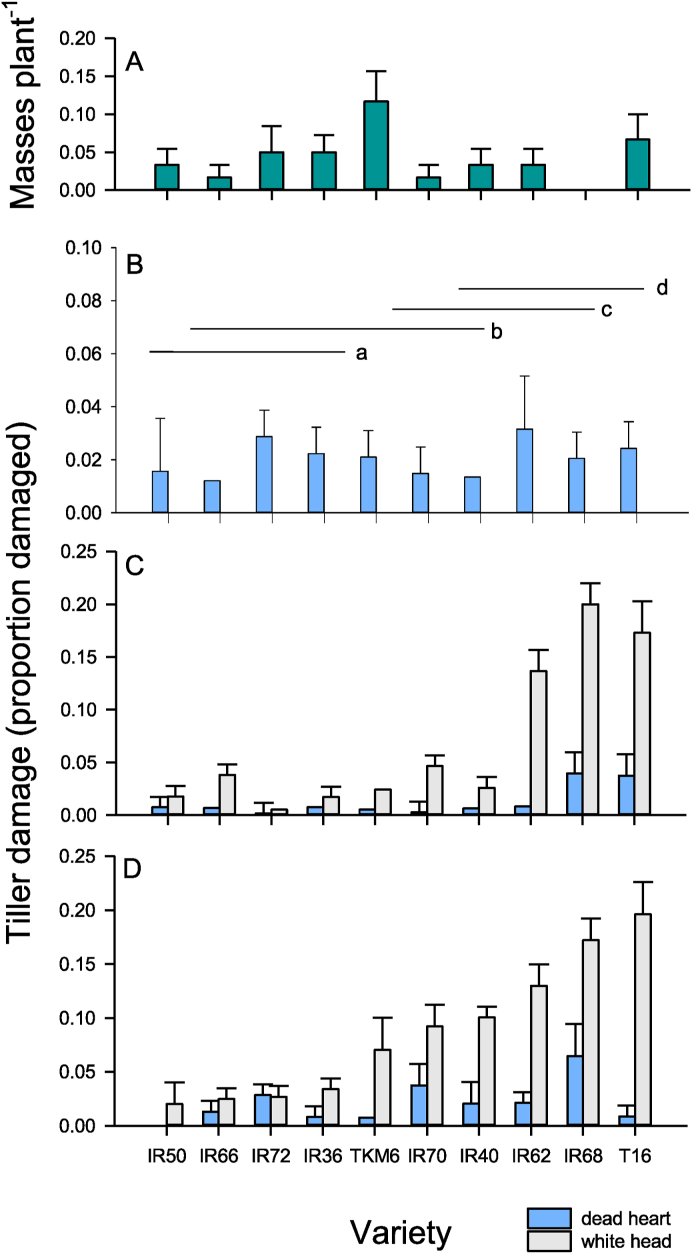
Results from field experiment with ten rice varieties. Data indicate (A) the number of YSB egg masses recorded in plots at 15 days after transplanting and tiller damage at (B) early, (C) mid, and (D) late season sampling. Standard errors are indicated. Homogenous variety groups are indicated based on Tukey tests (P > 0.05).